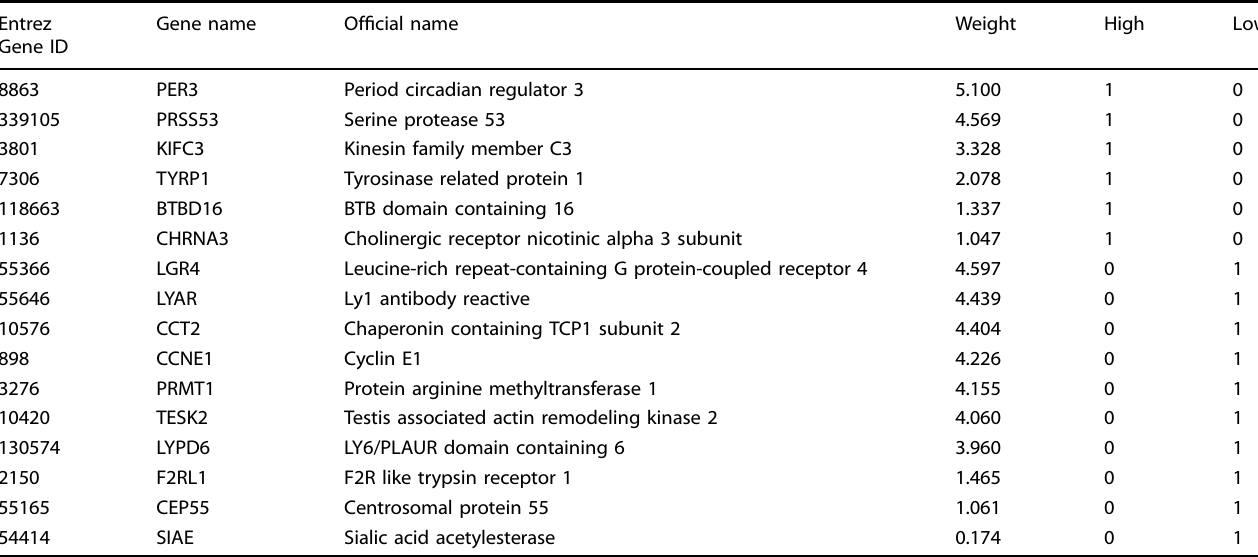
Table 1. The 16 genes necessary and suf fi cient for calculation of